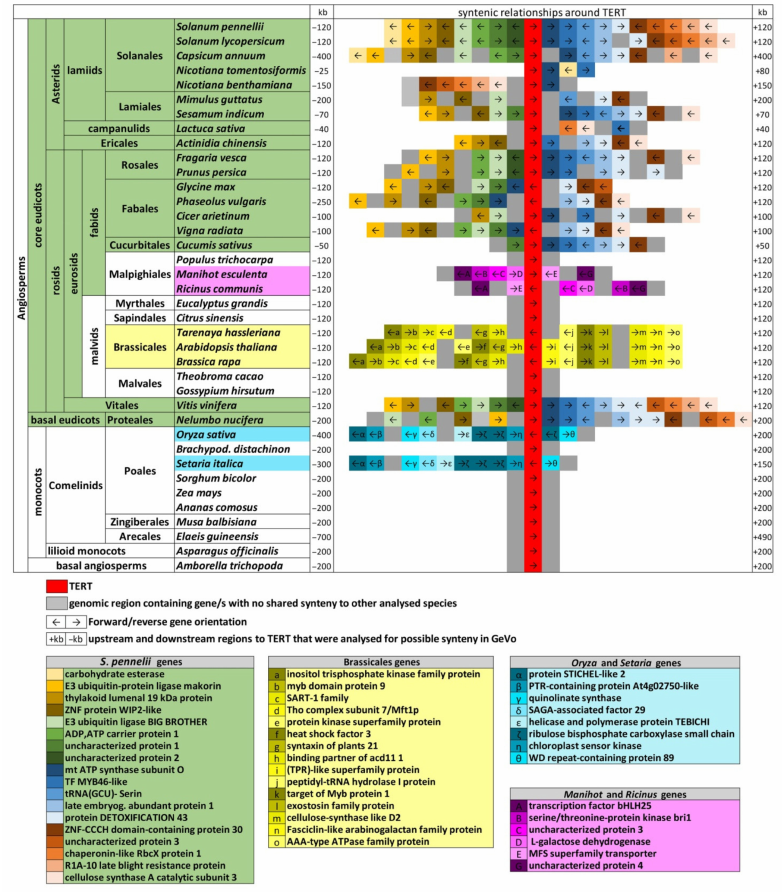
Figure 5. Graphical overview of TERT loci synteny across selected Angiosperms. Simplified pre- sentation of TERT synteny is based on syntelogs visualized in GEvo among indicated plant TERT loci identified directly by SynFind in CoGe or by BLAST in NCBI genome databases. Dominant eudicot-like synteny (green) and three other types of shared gene synteny among close relatives, as indicated (yellow, cyan, purple), were identified across tested species. Source data used for GEvo analysis are listed in Table S5. SynFind parameters—algorithm:last; gene window size:30; minimum number of